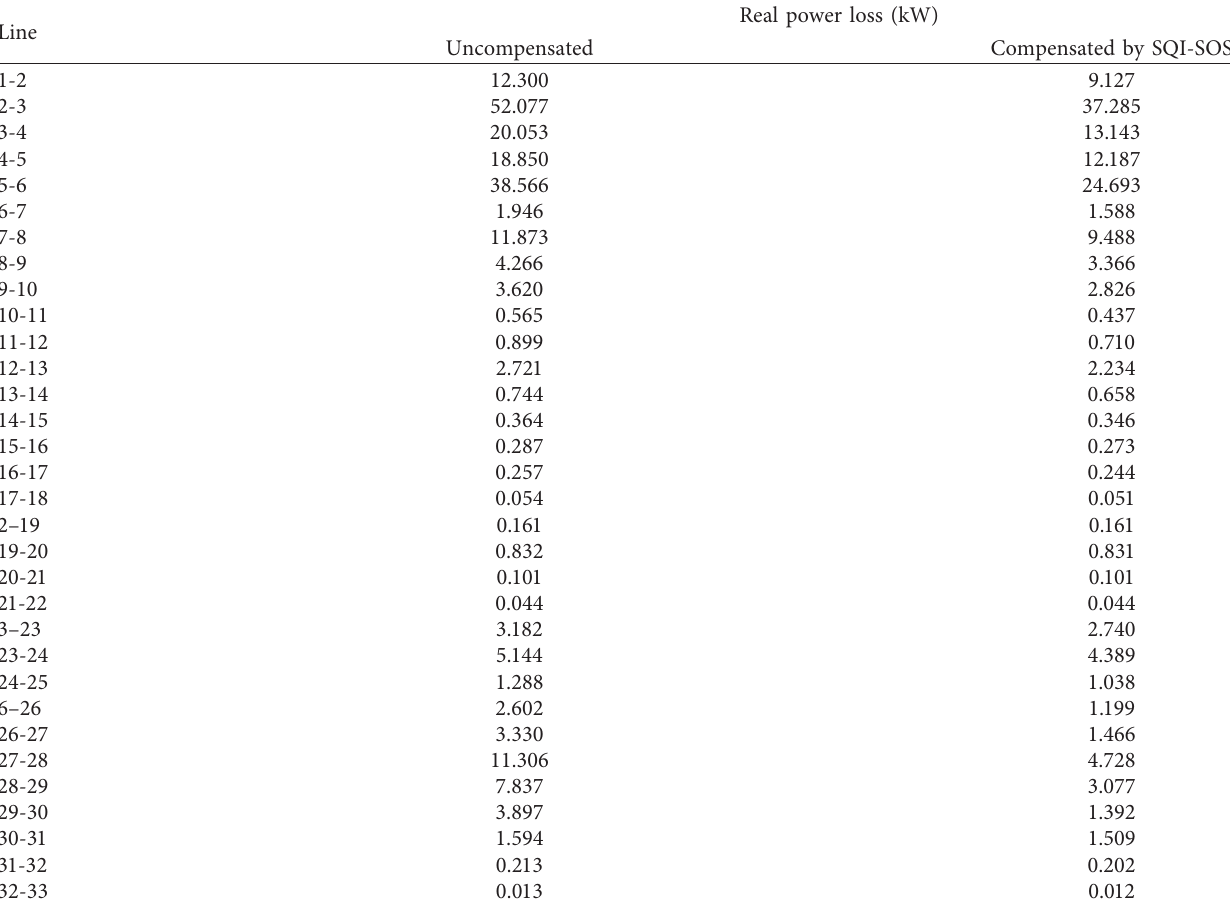
Table 6: Results of real power loss in all lines of the 33-bus system before and after the installation of capacitors.